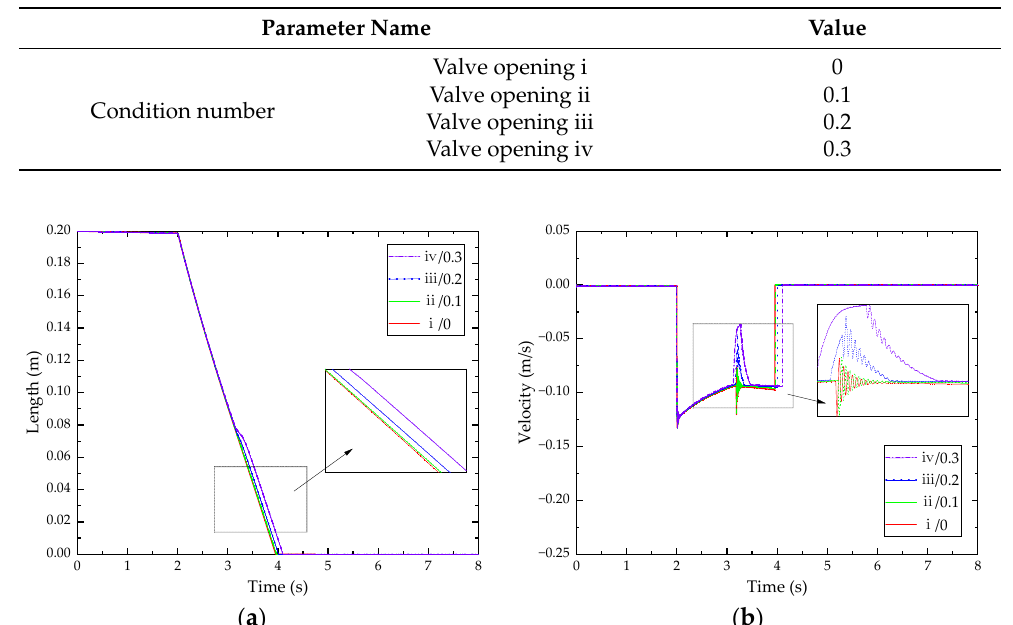
Figure 13. Simulation principle of pipe joint leakage. Table 10. Pipe joint leakage under different working conditions. Table 10. Pipe joint leakage under different working conditions.